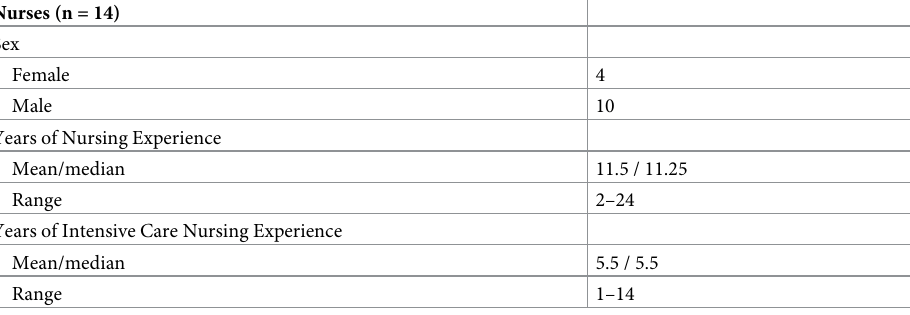
Table 2. Demographic characteristics of the